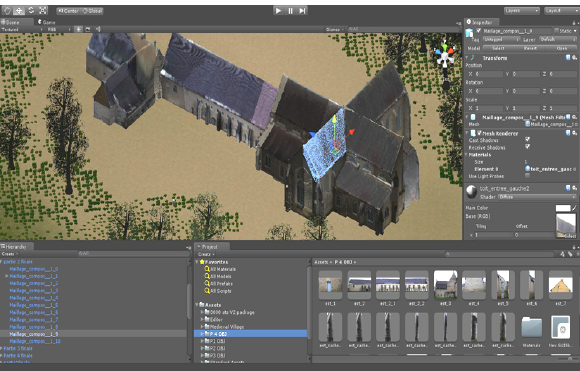
Figure 9. Virtual reality from